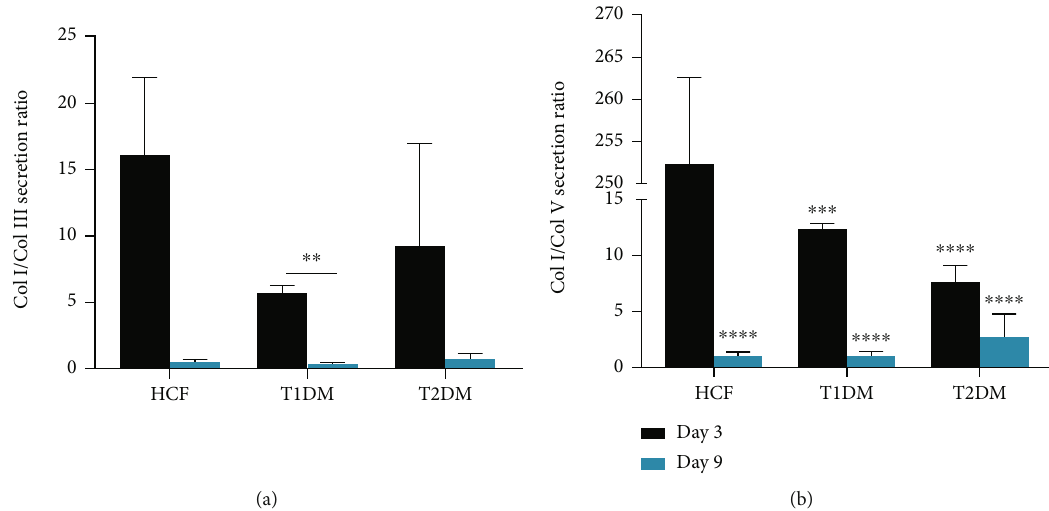
Figure 5: Collagen secretion ratio of (a) Col I/Col III and (b) Col I/Col V. T1DMs had a signi fi cant di ff erence between its day 3 and 9 Col I/Col III ratio. For the Col I/Col V ratio, both days of the T1DM and T2DM showed signi fi cant decreases of secretion, as well as the HCFs at day 9. Welch ’ s unpaired t -test and/or ordinary one-way ANOVA ( n = 4 ) was used to analyze the results. Error bars represent standard deviation ( ∗∗∗∗ denotes p < 0 : 0001 and ∗∗ denotes p < 0 : 01 ).